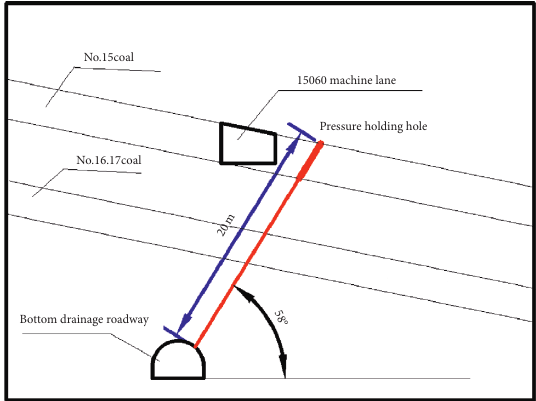
Figure 4: Sectional view of pressure holding hole.